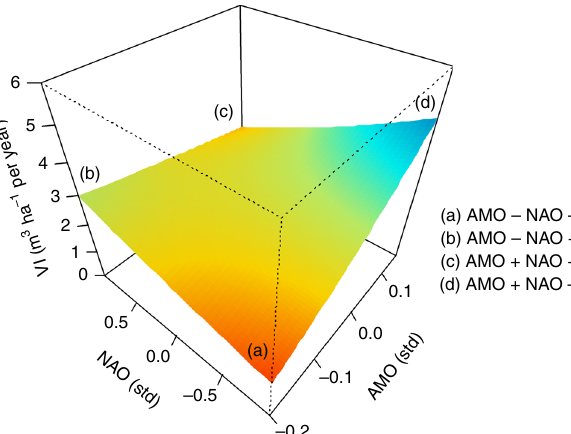
Fig. 1 Volume increment as function of NAO and AMO. Three-dimensional regression plot showing predicted wood volume increment (VI, as surrogate of forest productivity) responses to standardized North Atlantic Oscillation (NAO) and Atlantic Multidecadal Oscillation (AMO) interactive effects. The colored layout (i.e., from red to blue increasing VI values) represents the marginal response curve when the other variables in the best model are kept to mean values (i.e., mean tree size and the calendar year). Letters indicate the areas in the response curve related to each potential sign of NAO and AMO combination